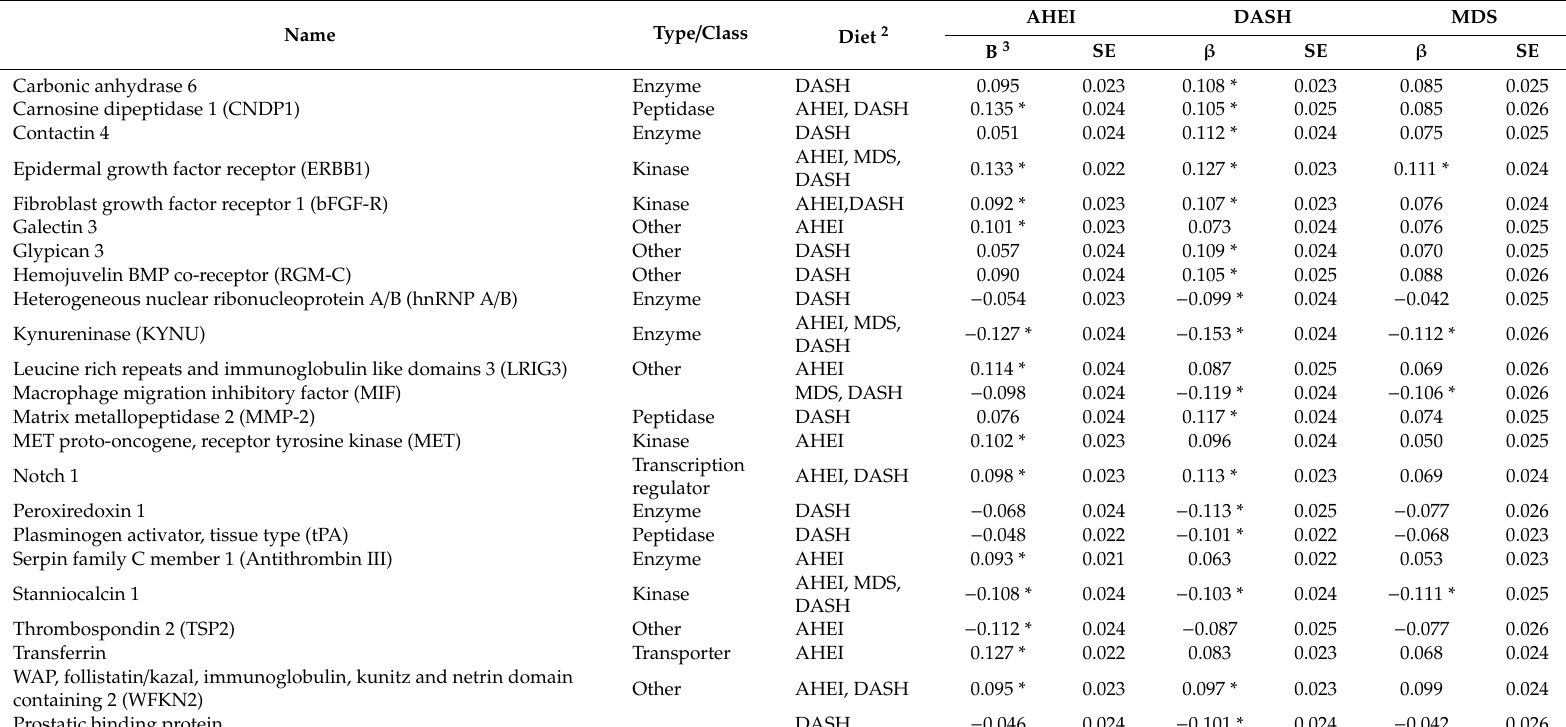
Table 2. Top significant associations of dietary patterns with plasma protein concentrations 1